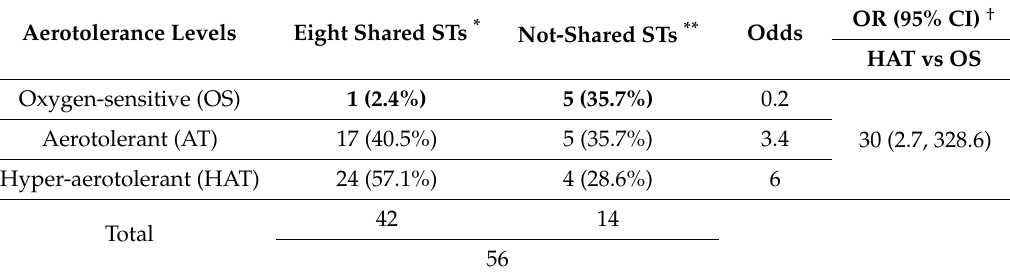
Table 4. Comparison of the proportion of shared multi-locus sequence typing (MLST) sequence types (STs) with those of the human source (PubMLST) and non-shared STs according to aerotolerance levels of C. coli